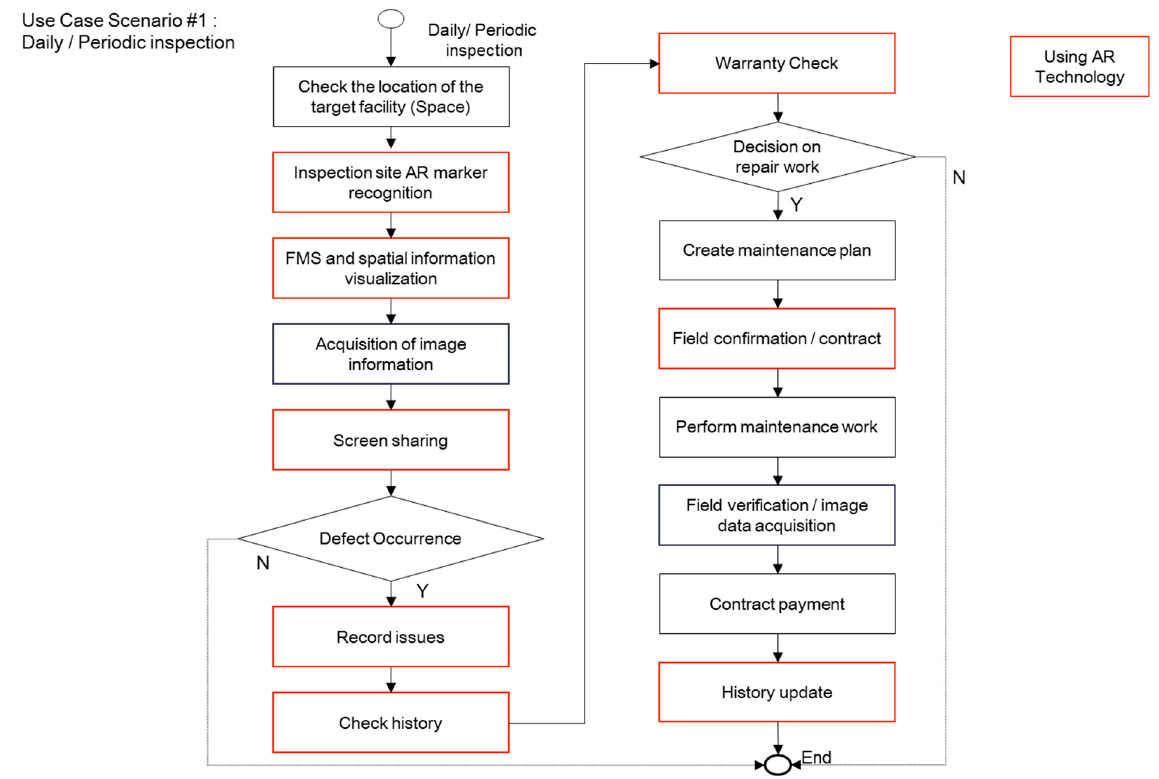
Figure 4. Detailed tasks scenario for daily or routine inspection.